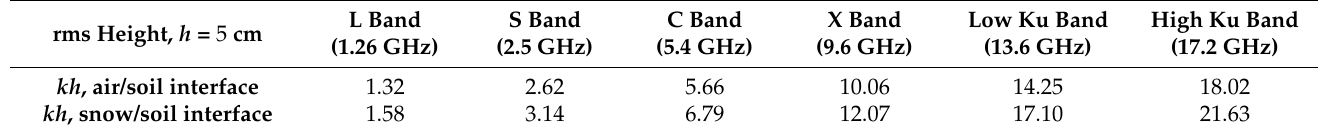
Table 9. kh of 5-cm rms height for air/soil and snow/soil interface from L- to